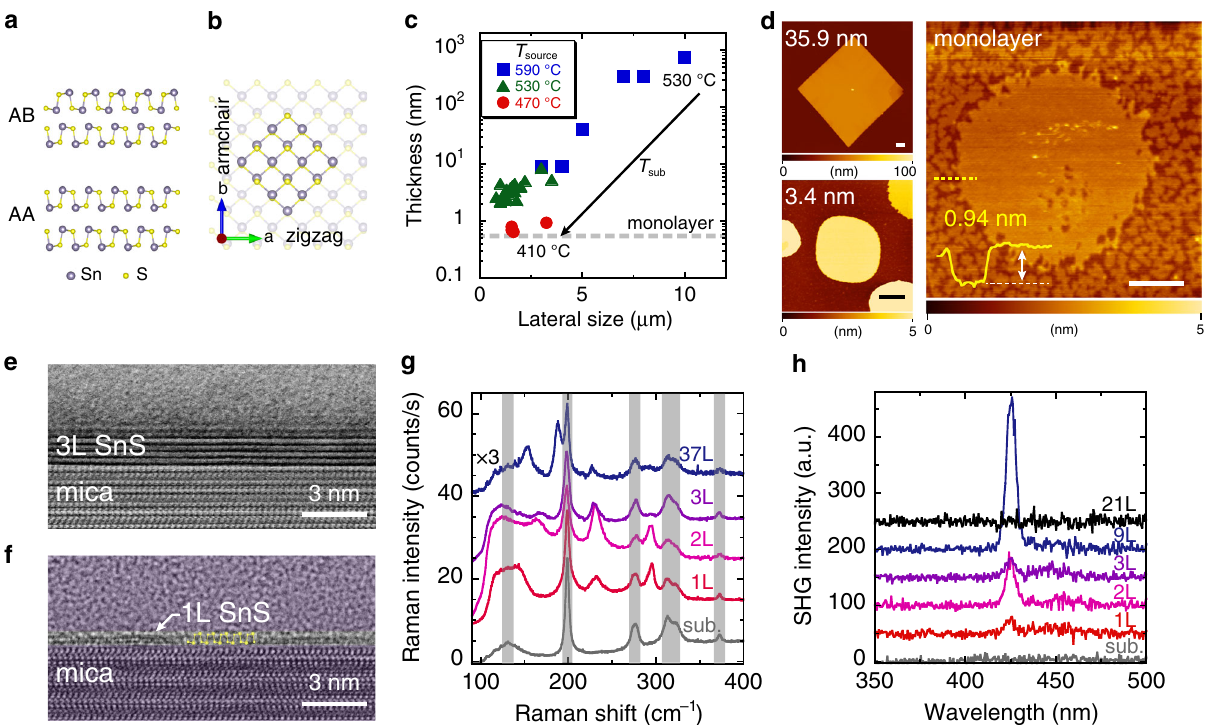
Fig. 1 Characterization of few-to-monolayer SnS. a Cross-sectional crystal structures of SnS along the armchair direction with different stacking sequences: non-centrosymmetric AA and centrosymmetric AB staking. b Top view of crystal structure of monolayer SnS, whose twofold axis is along the armchair direction. Highlighted area shows thermodynamically stable facets. c The minimum thickness versus lateral size of PVD grown SnS with changing T T source and sub . d AFM topographic images of SnS crystals with different thicknesses from bulk to monolayer. The scale bars represent 1 sectional bright- fi eld STEM image of trilayer SnS. f Cross-sectional TEM image of monolayer SnS along the armchair direction. As guide to the eye, all of the region except the SnS crystal is shaded, and the atomic model is overlaid on the TEM image. g Thickness dependence of Raman spectrum for SnS at 3 K. The peaks in the hatch come from the mica substrate. h SHG spectra for SnS with different thicknesses from bulk to monolayer at